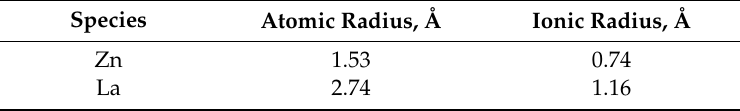
Table 1. Comparison between Zn and La atoms and ions